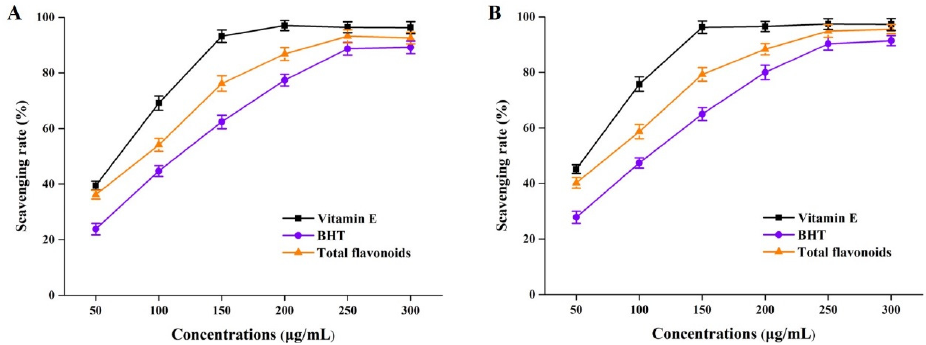
Figure 5. DPPH free radical ( A ) and DPPH free radical ( B ) scavenging rates of total flavonoid compounds in vitro. BHT, butylated hydroxytoluene.